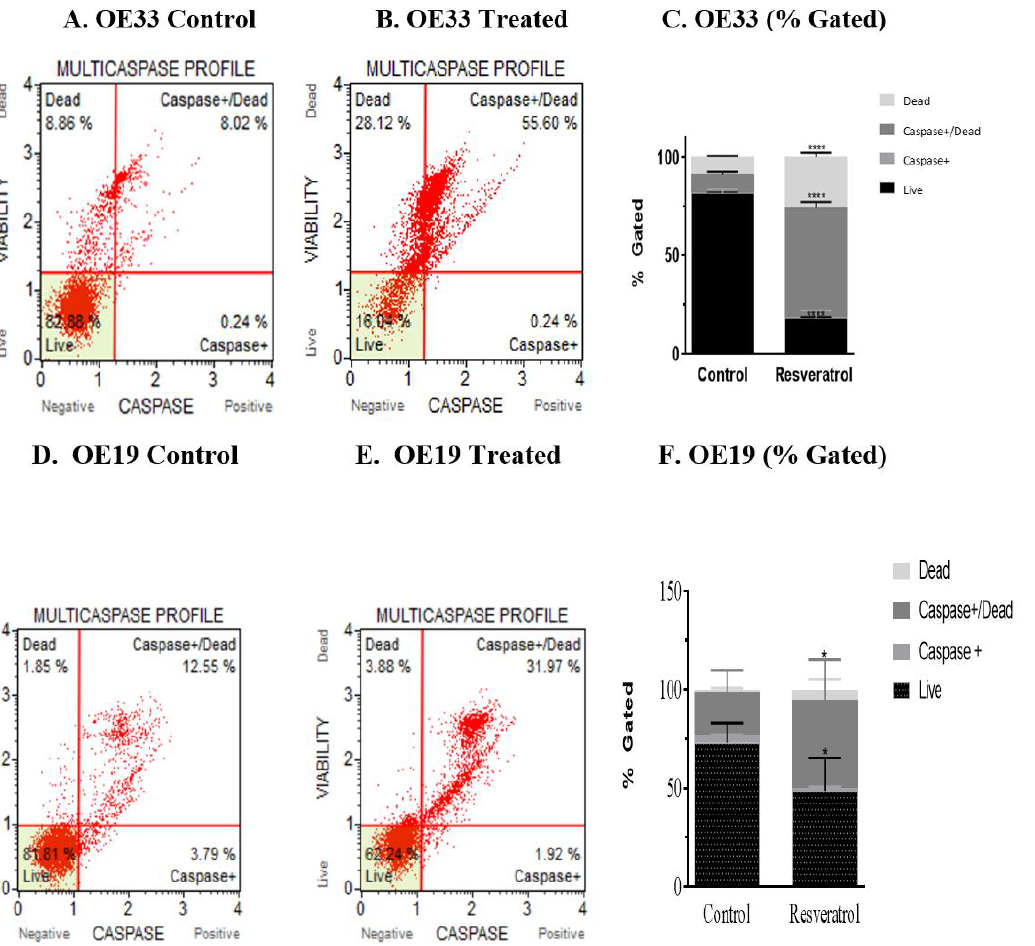
Figure 3. Activation of caspases on treatment with resveratrol in OE33, OE19 and FLO-1 cells. Cells were seeded at a density of 62,500 cells/well in 12-well plates and treated with resveratrol at 100 µM for OE33 cells for 72 h. Three inde- pendent experiments were performed. ( A ) Representative scatter plot from Muse MultiCaspase assay for the control group. ( B ) Representative scatter plot from Muse MultiCaspase assay for the resveratrol-treated group. ( C ) Profiles (% gated) of the control and treated group, respectively. Similarly, OE19 and FLO-1 cells were treated with resveratrol at an